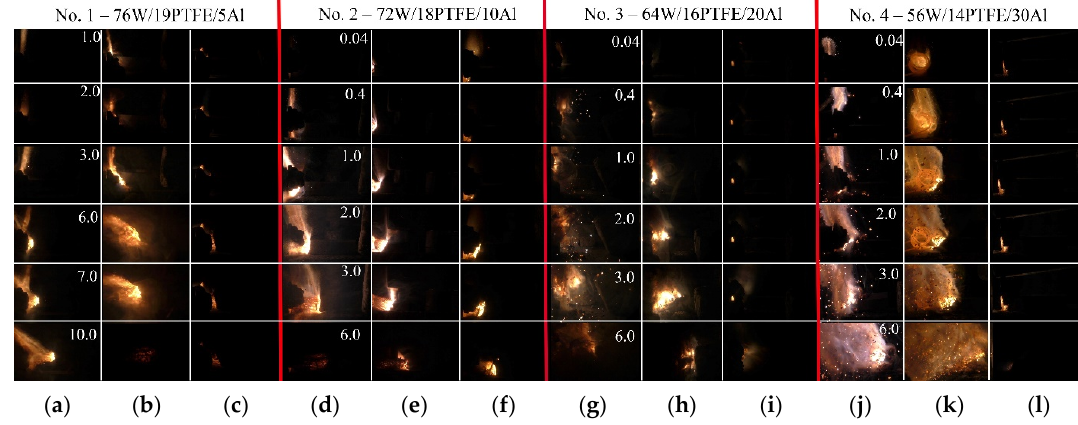
Figure 8. Video frames of the combustion in the W/PTFE/Al system, time (s): ( a , d , g , j ) air ( b , e , h , k ) argon, ( c , f , i , l ) vacuum.